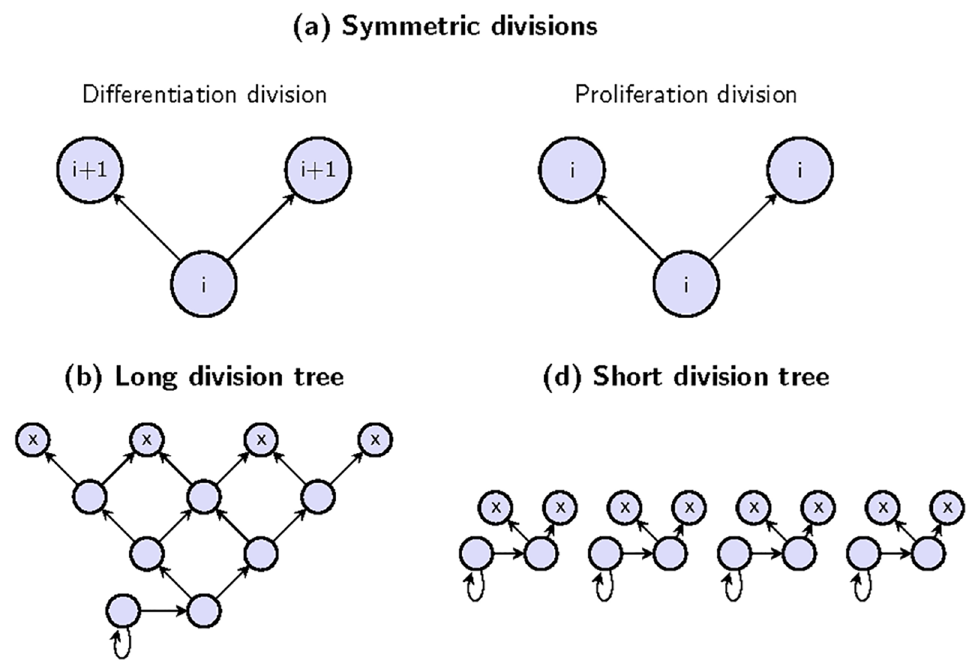
Fig 1. Schematics showing key concepts of the paper. (a) Two types of symmetric divisions: self-renewals and differentiations. Each circle represents a cell, and i denotes the i th compartment, while i + 1 denotes the ( i + 1)th compartment. Panels (b) and (c) demonstrate the division chains that replenish 8 differentiated cells eliminated from the top compartment. Dead cells are denoted by X’s and arrows show divisions. Cells are arranged in horizontal layers corresponding to compartments. Only the dividing cells are shown (for example, there may be more than 4 cells in the second to top compartment in panel (b)). In (b), the dead cells are replaced by a longer division tree, and in (c) by four shorter division